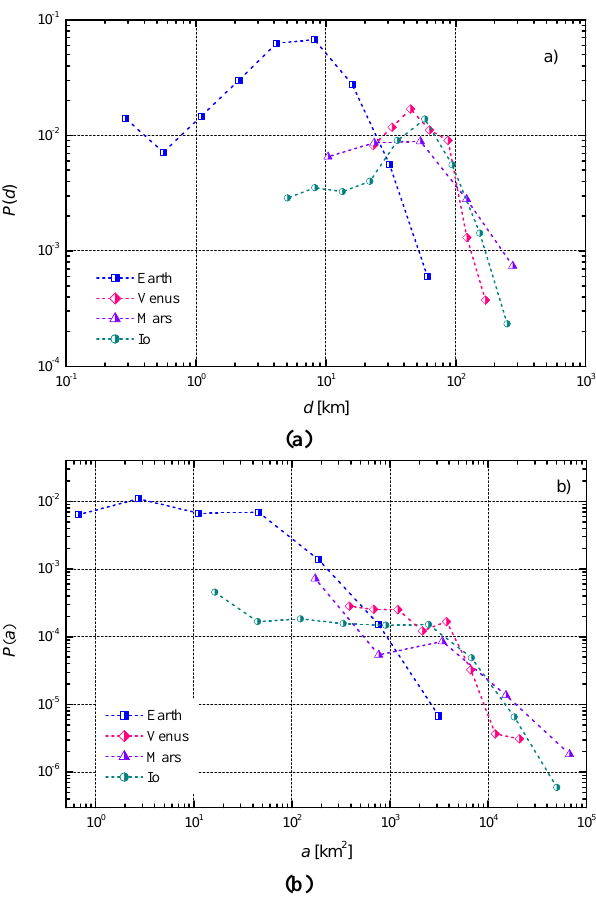
Fig. 1. Distributions of caldera sizes for the Earth, Venus, Mars and Io. (a) Caldera diameters inkm, (b) Caldera areas inkm 2